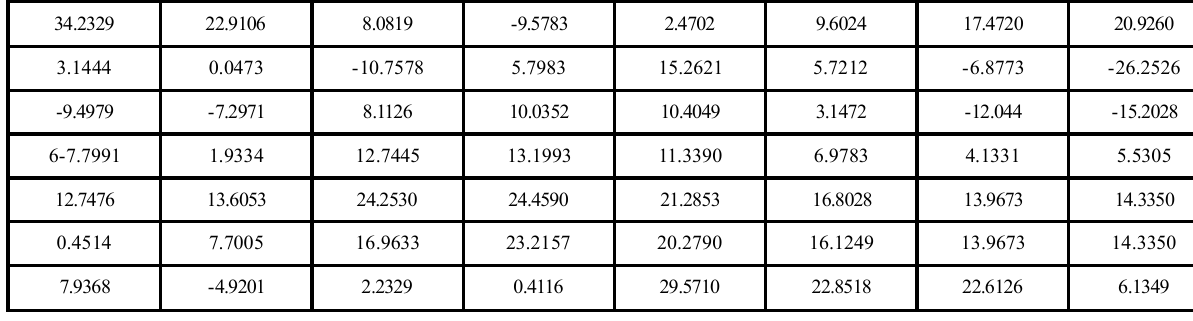
TABLE 2. DWT COEFFICIENTS OF ARBITRARY DATA